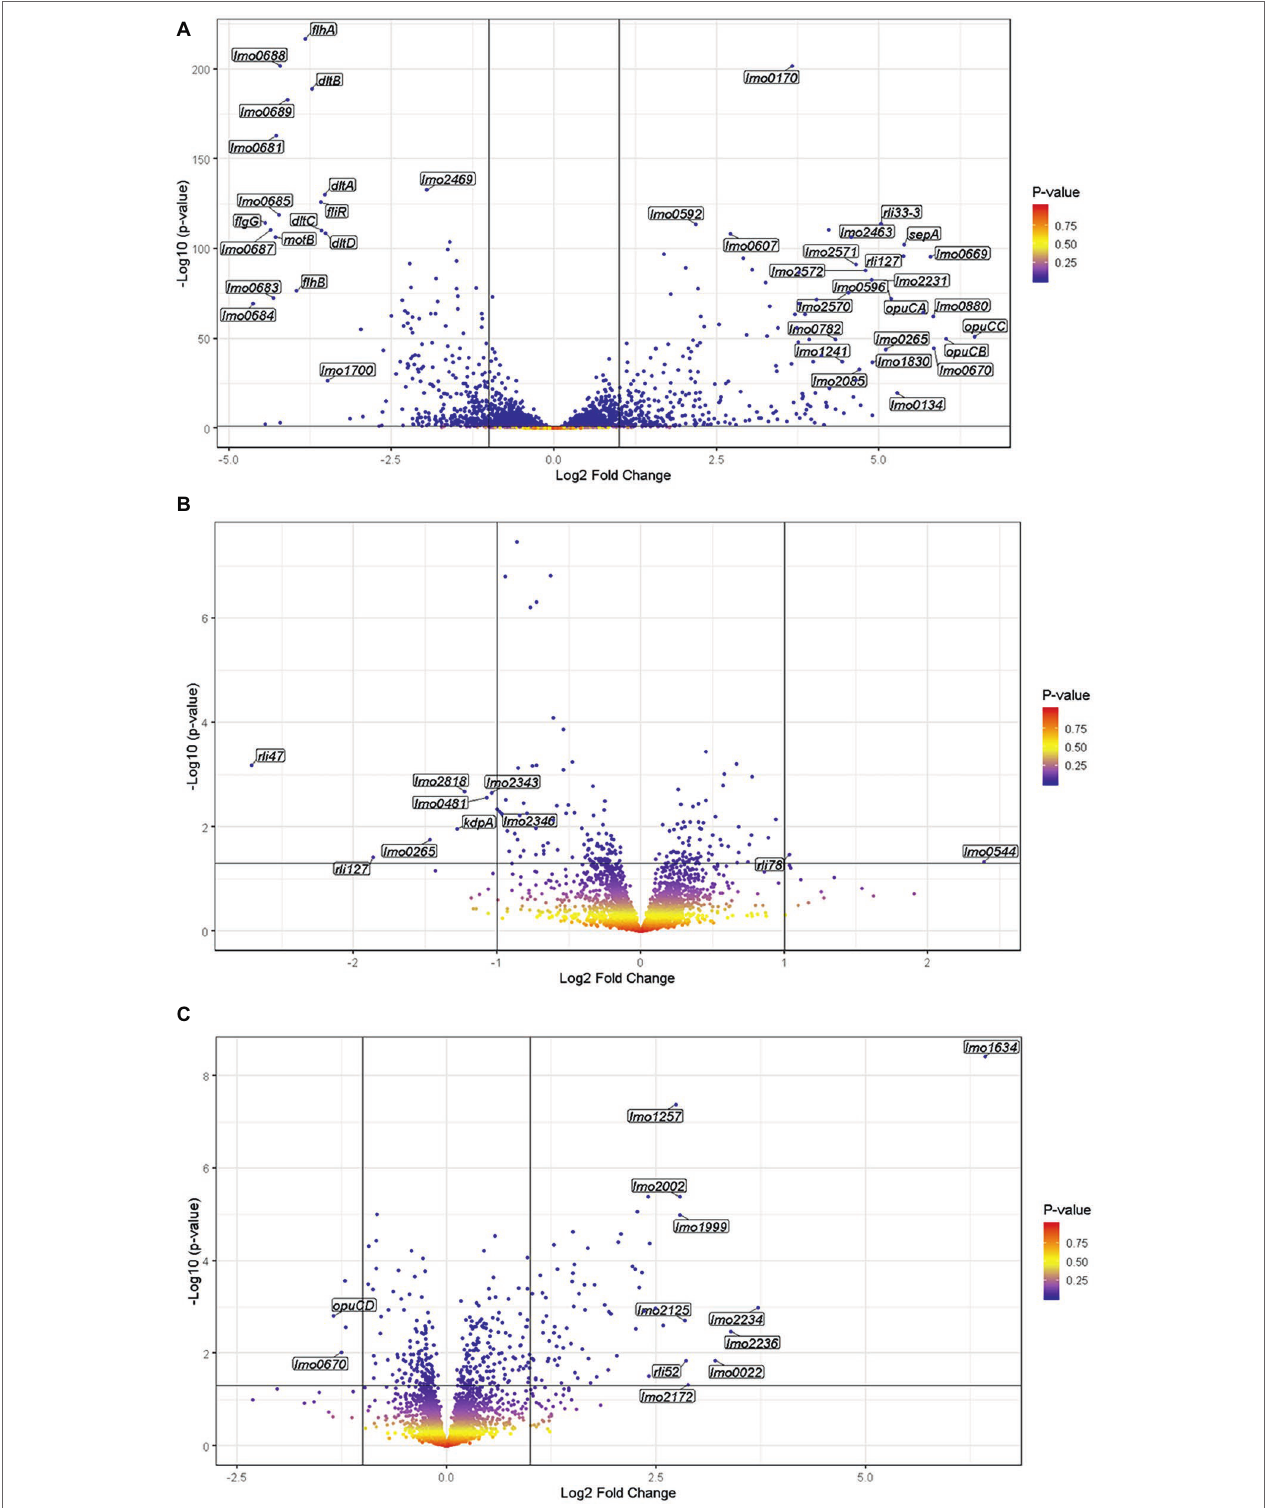
FIGURE 5 | The exposure of L. monocytogenes to visible light significantly alters the transcription of 603 genes. RNA was sampled from exponentially growing cells exposed to either 0.6 mW cm − 2 470 nm light or darkness for 20 min at 30 ° C. Gene transcription was measured by RNA seq. and differential gene expression and the values of p were determined using DESeq2. The wild-type (A) , Δ sigB mutant (B) , and rsbL -C56A mutant (C) were included in this